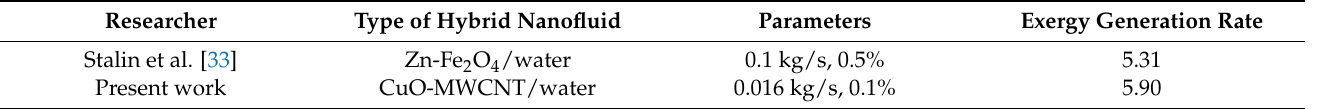
Table 3. Comparison with other hybrid